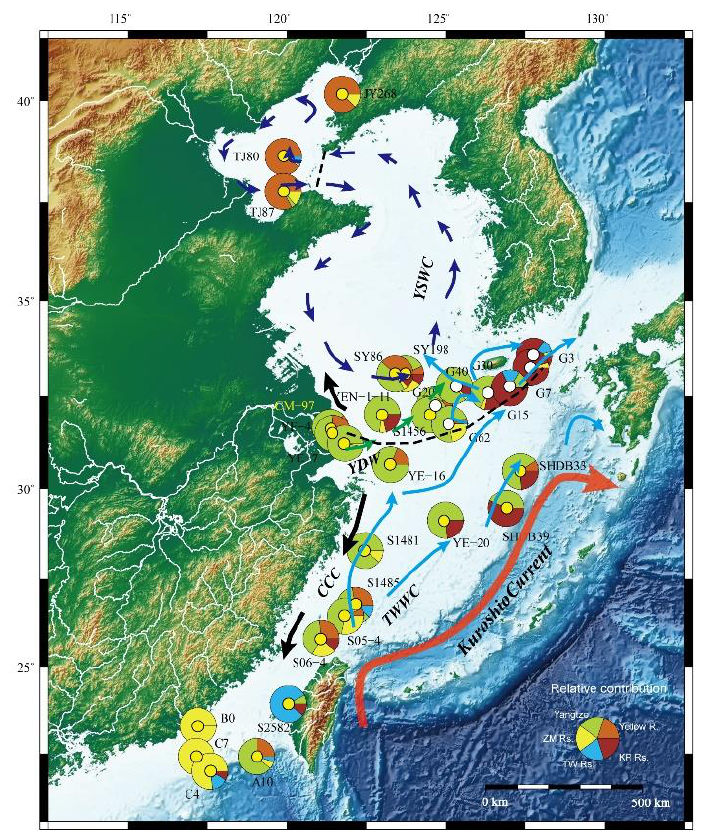
Figure 5. Spatial distribution of the mixing coefficients illustrating the relative contributions of zircons in the ECSs from five major river sources. The relative contributions from different sources at sampling sites are shown in the pie plots.